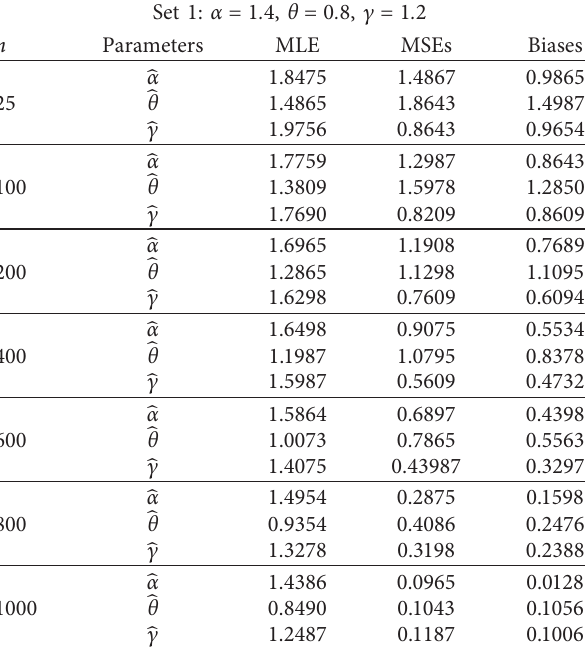
Table 1: Simulation results of NE-W distribution.